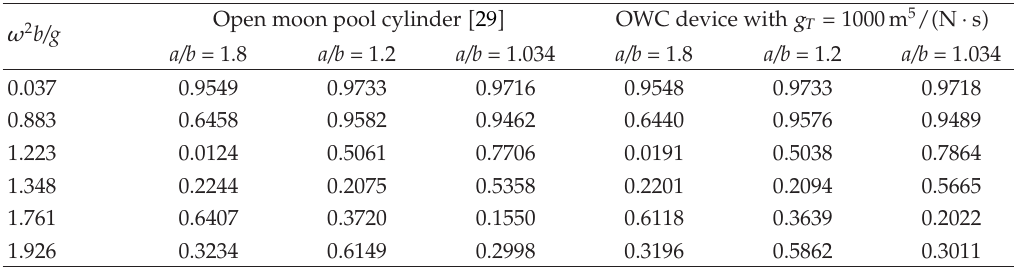
Table 3: RAOs of heave motion x 30 / (cid:4) H/ 2 (cid:5) versus ω 2 b/g for a floating OWC device with turbine parameter g T (cid:8) 1000m 5 / (cid:4) N · s (cid:5) . Comparisons with an open moon pool cylinder.